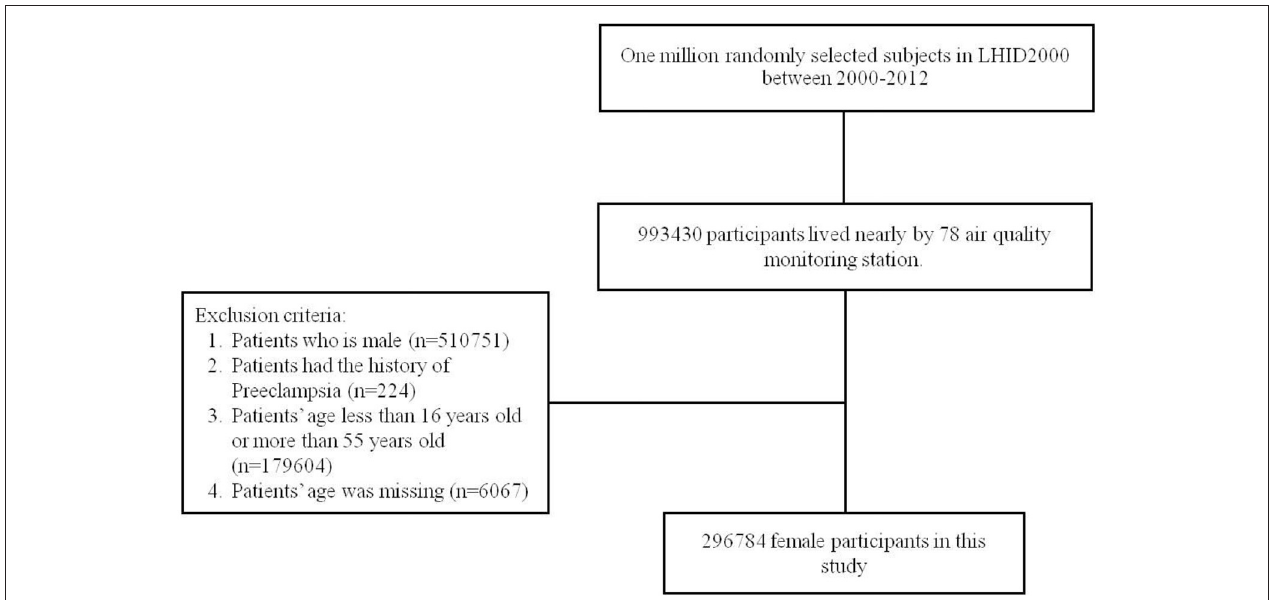
FIGURE 1 | Flow chart of this